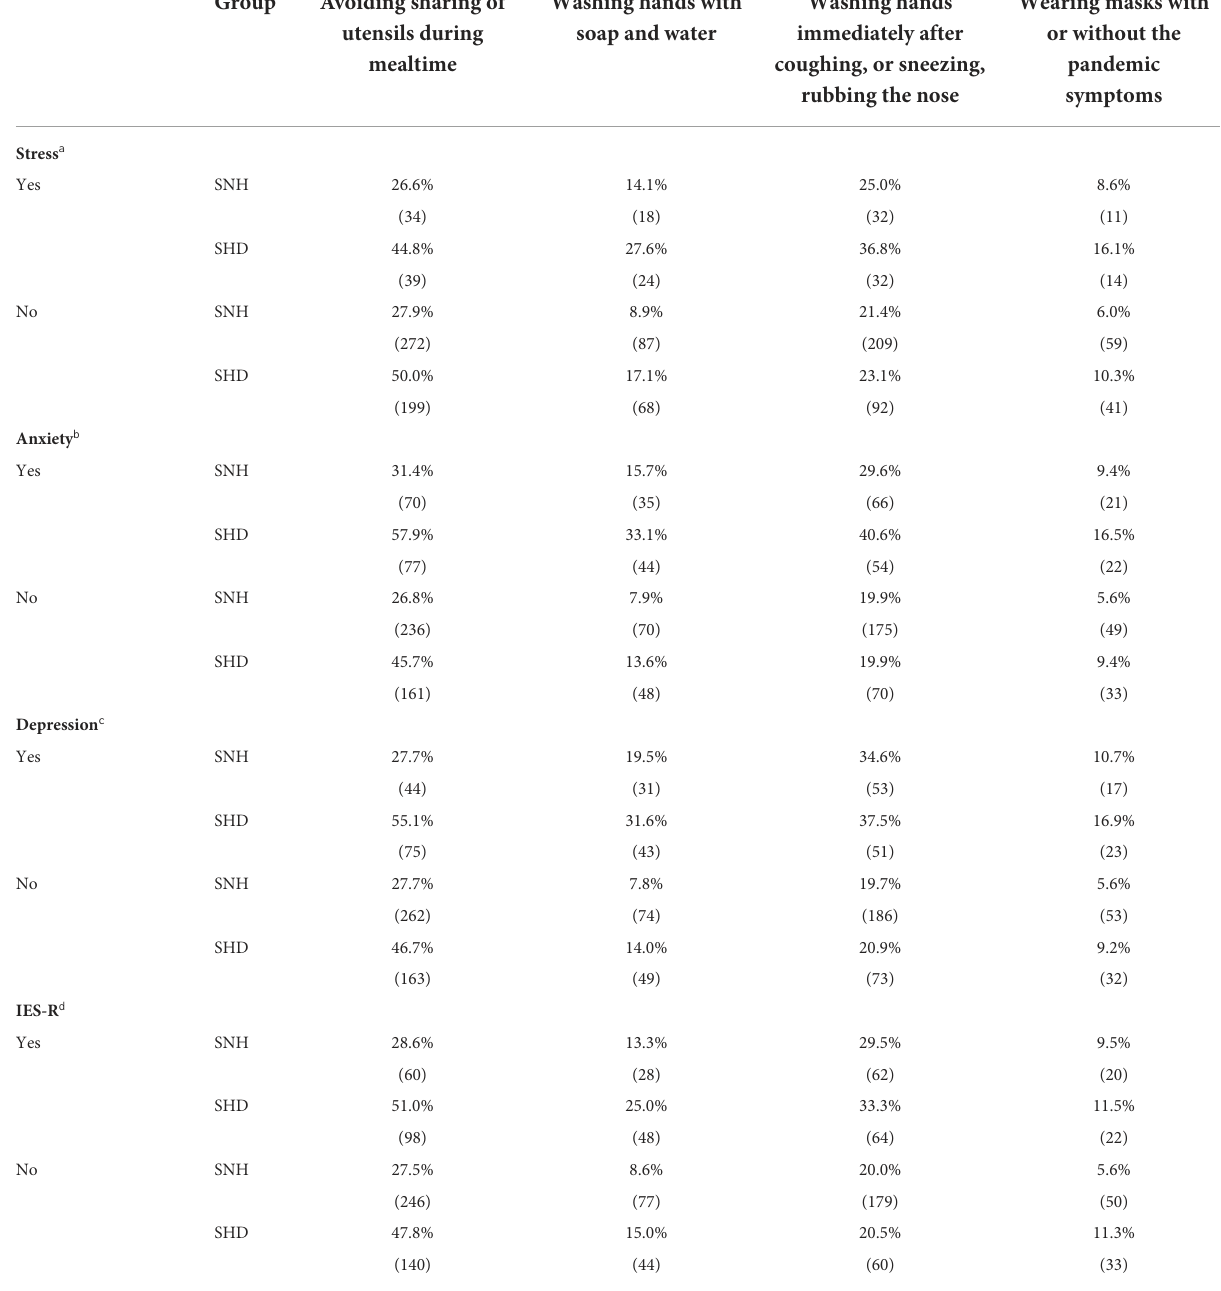
TABLE 2 The percentage of mental health status and psychological impacts with health behavior of ≤ 2 high-risk prevention scores among students. Group Avoiding sharing of Washing hands with Washing hands Wearing masks with utensils during soap and water immediately after or without the mealtime coughing, or sneezing, pandemic rubbing the nose symptoms Stress